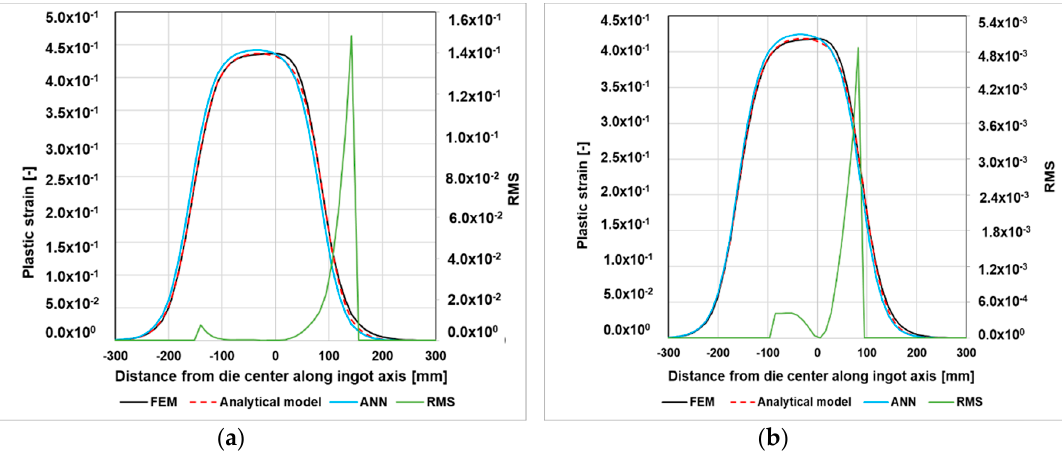
Figure 12. Total equivalent plastic strain as a function of length for Sb 0 = 300 mm, reduction of 25% for first stroke at ( a ) 800 °C, ( b ) 1200 °C.